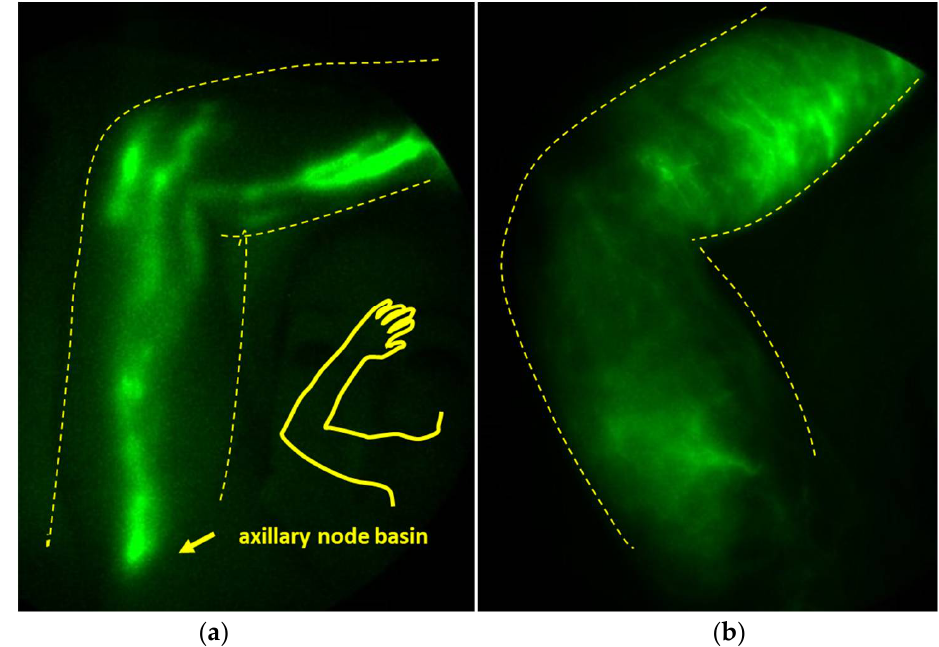
Figure 1. Near-infrared fluorescence lymphatic imaging (NIRF-LI) of the right upper-proximal extremity, including the axilla, depicting ( a ) a healthy lymphatic structure with visible lymphatic vessels and axillary node basin, ( b ) dermal backflow.